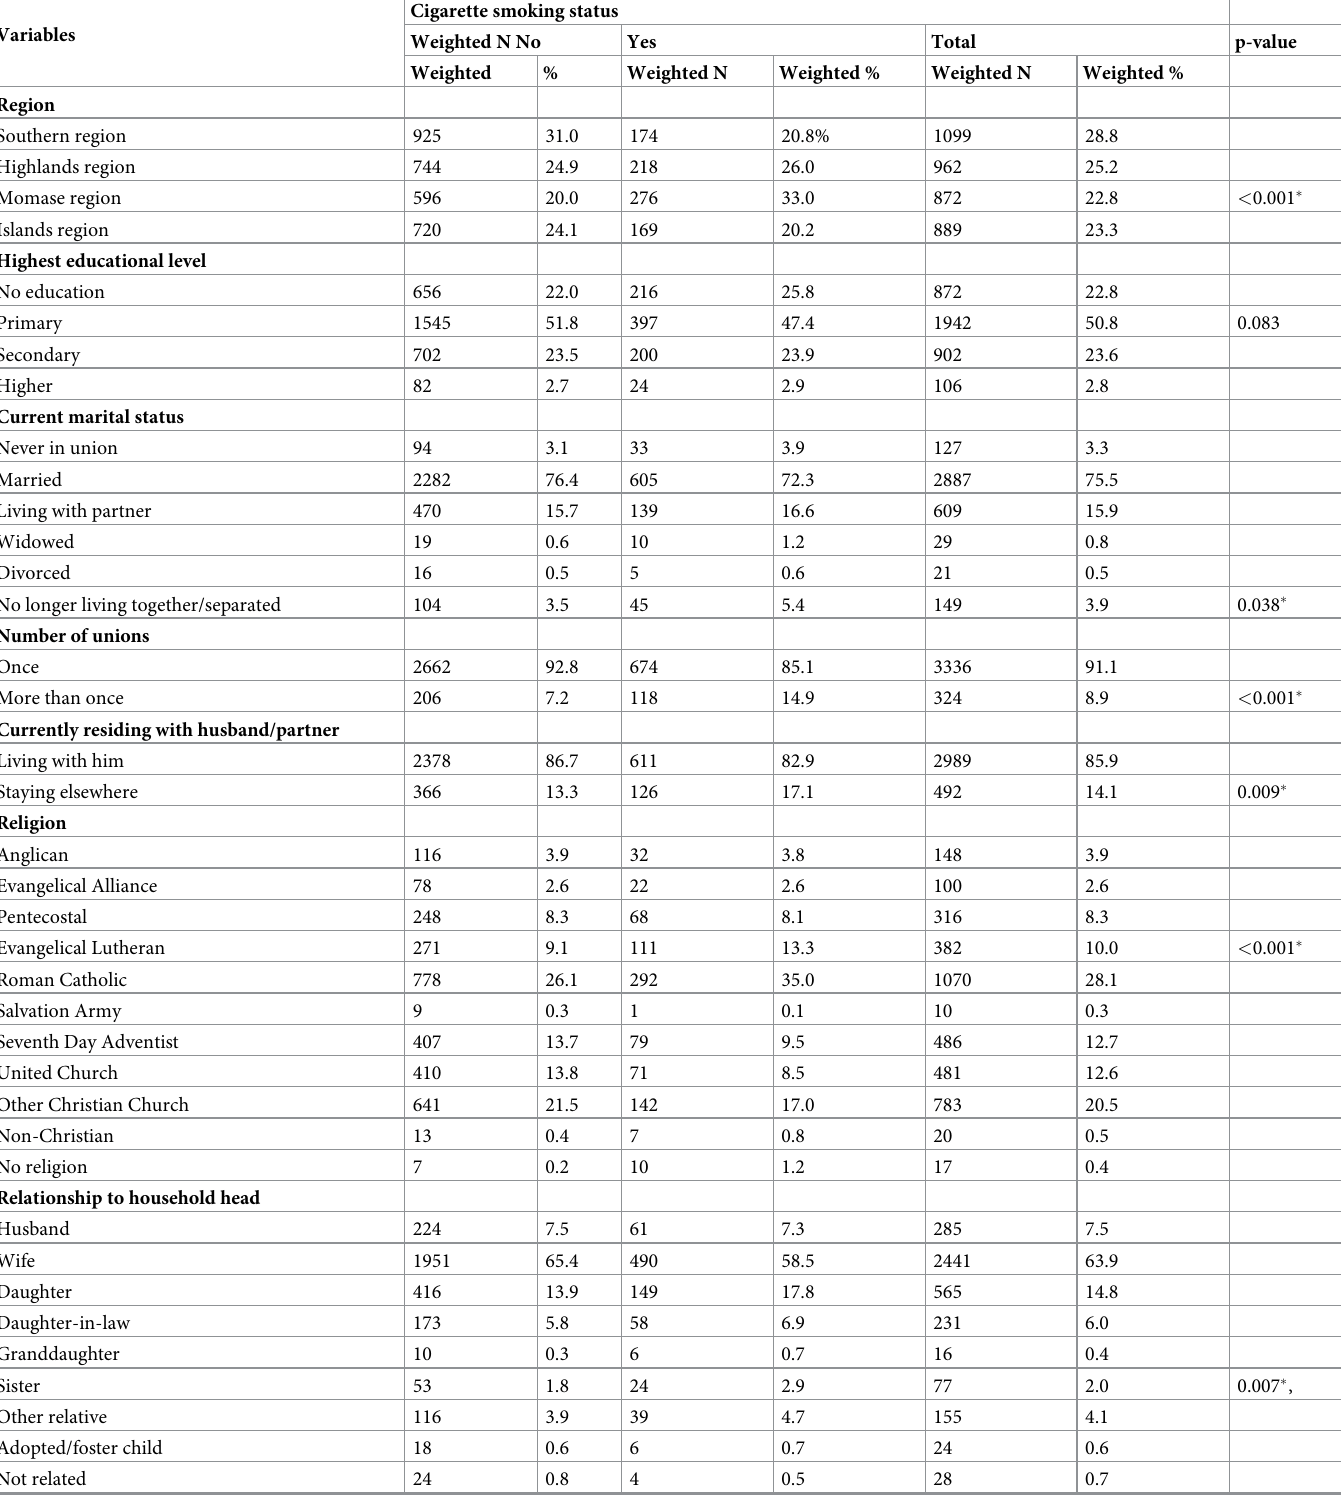
Table 1. Demographic and socio-economic characteristics of the participants by cigarette smoking status (N =